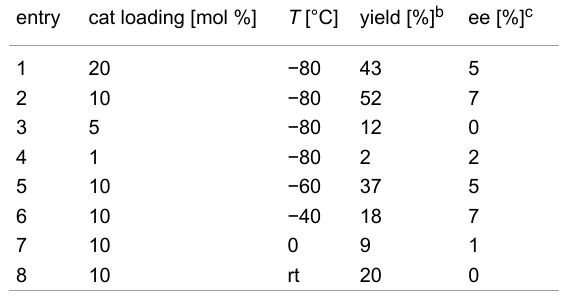
Table 10: Hydrogen-bond-catalyzed addition of silyl ketene acetals 11a – d with 1-chloroisochroman ( 18 ) to product 19 with chlorosilanol 8 and silanediol 9 in different solvents a (Scheme 7). entry cat. solvent